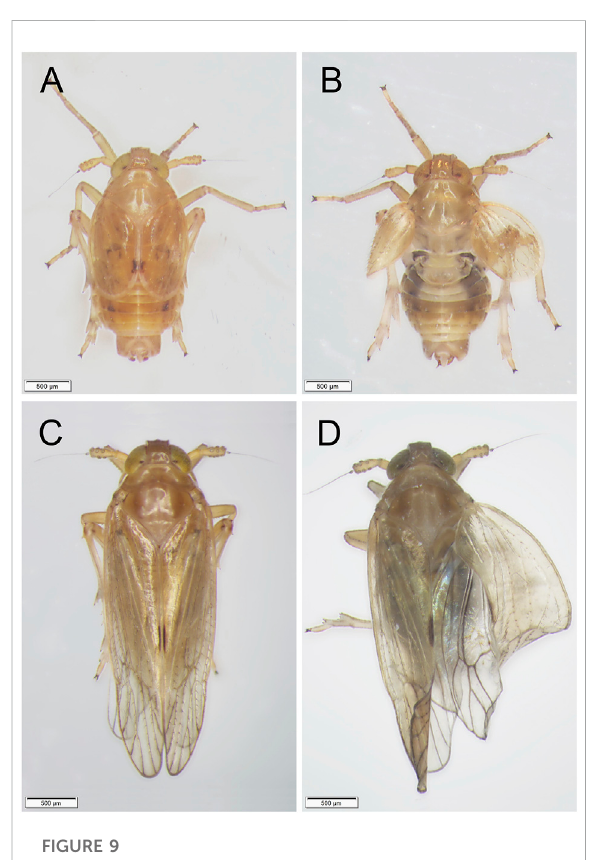
FIGURE 9 Phenotypes of BPH adults developed from nymphs treated with ds Nljagged . (A,B) : Phenotypes of BPH adults of the Brachypterous strain with ds GFP -treatment (A) or ds Nljagged - treatment (B) . (C,D) : Phenotypes of BPH adults of the Macropterous strain with ds GFP -treatment (C) or ds Nljagged - treatment (D) . Third-instar nymphs were injected with 100 ng ds Nljagged . Equivalent ds GFP was used as a